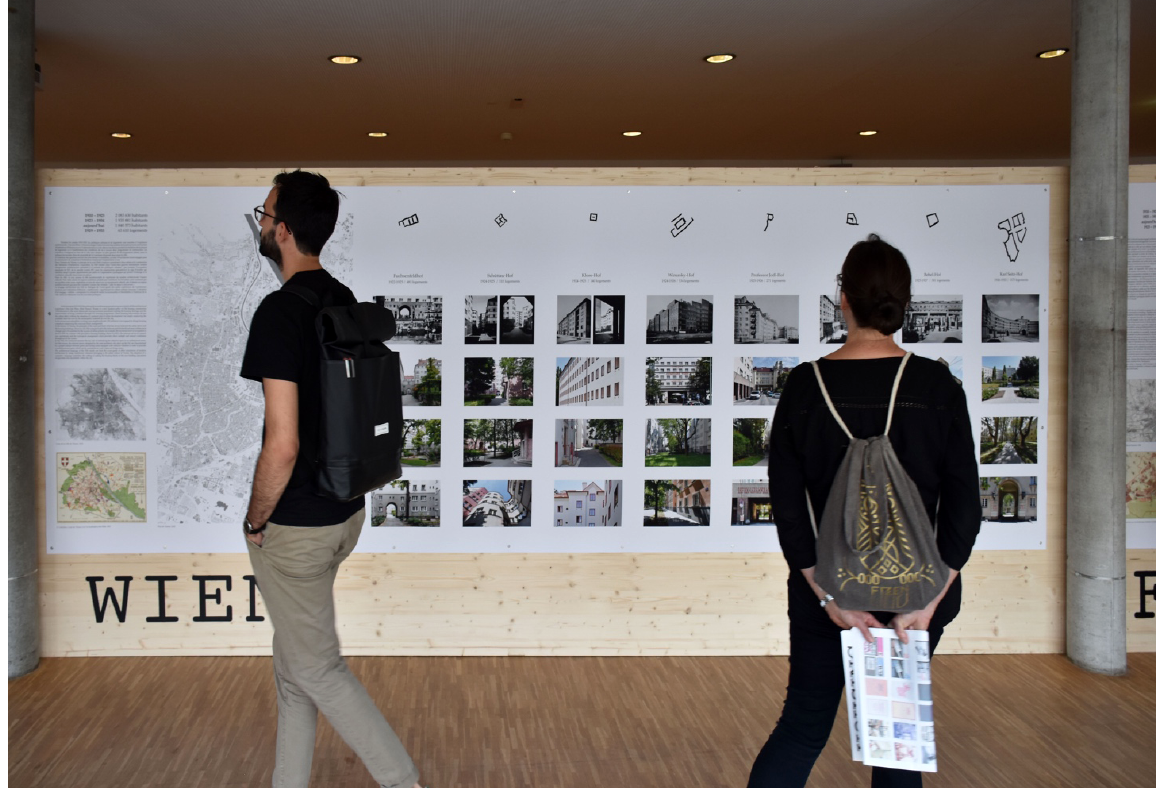
Figure 8. Second section: the panel dealing with Vienna urban policy. Source: